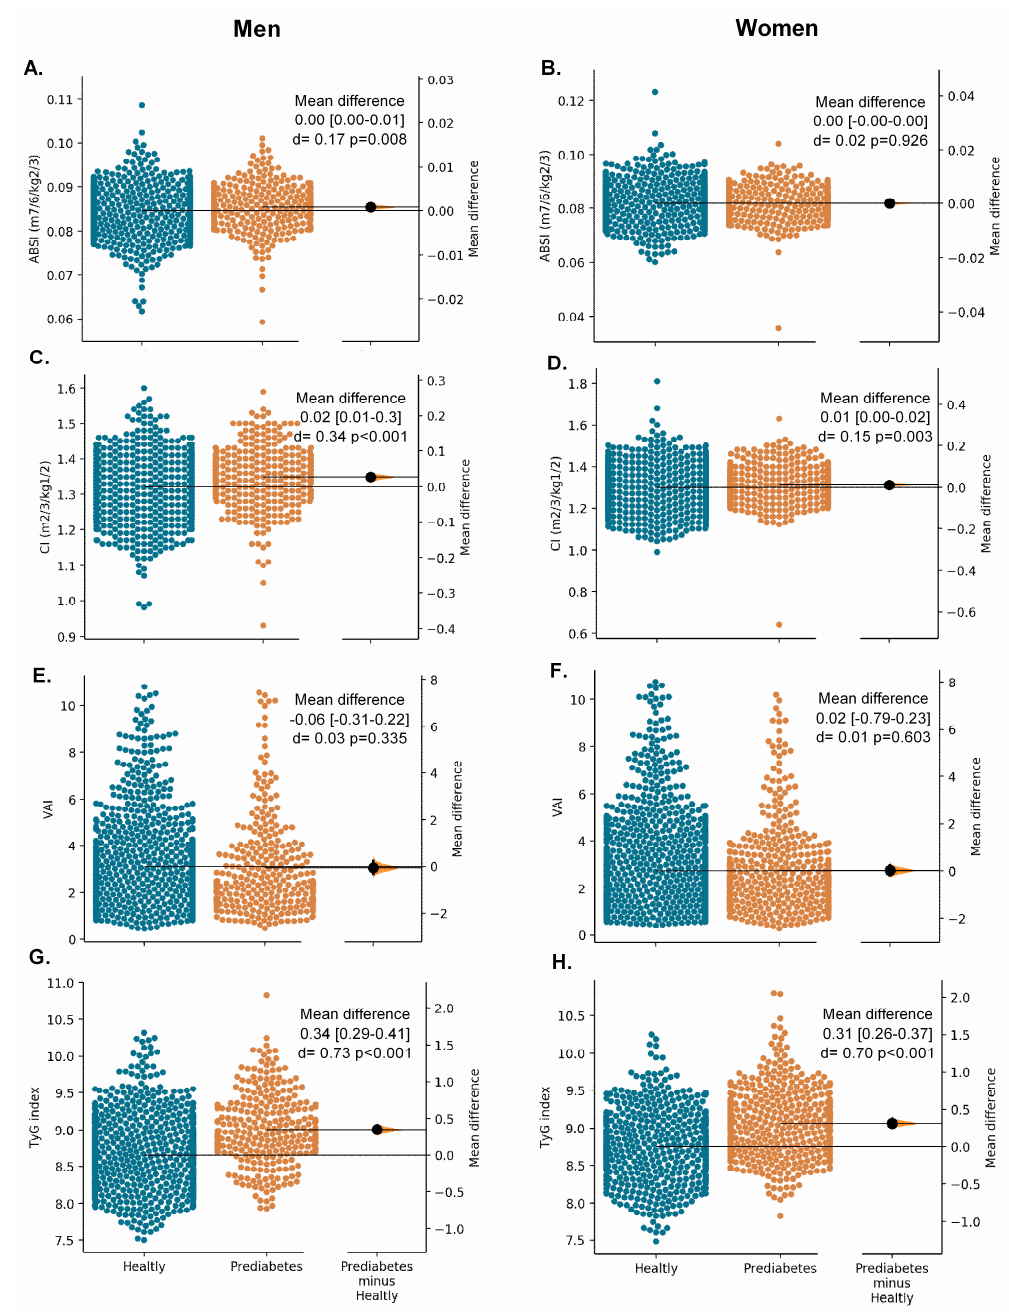
Figure 3. The Gardner–Altman plots for unadjusted surrogate obesity indices (ABSI, C, VAI, and TYG) according to glycaemia status and sex.